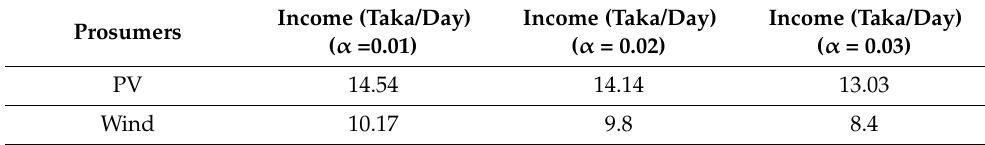
Table 4. Income of the prosumers at between different values of α in a typical day .